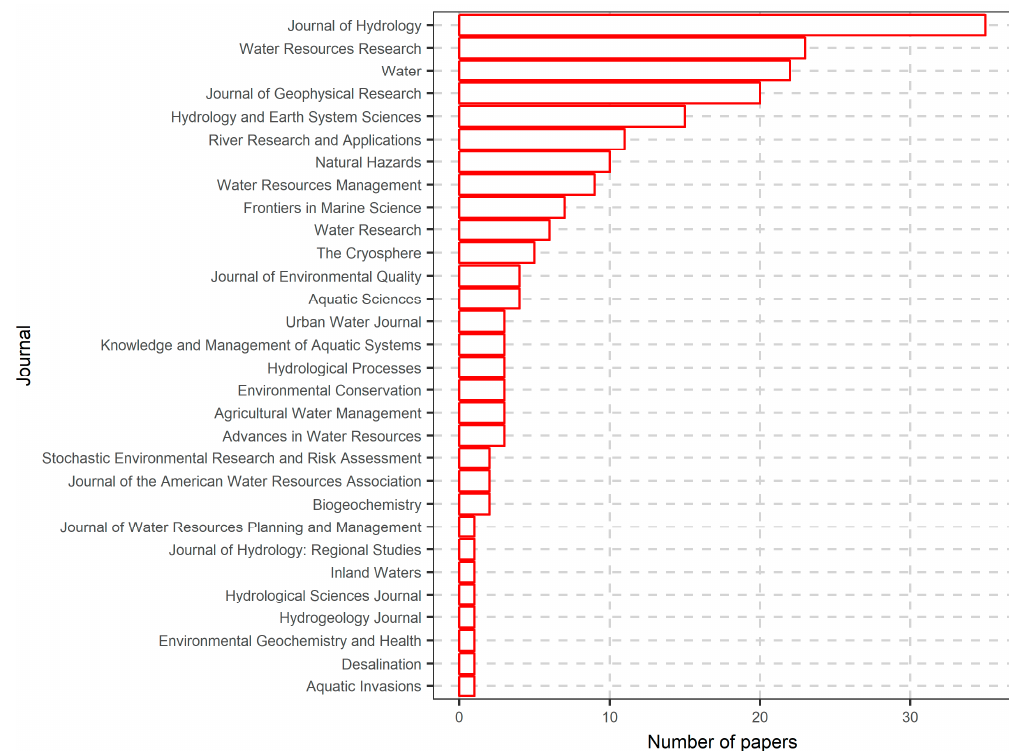
Figure 3. Number of published papers per Journal that include RF-related implementations.